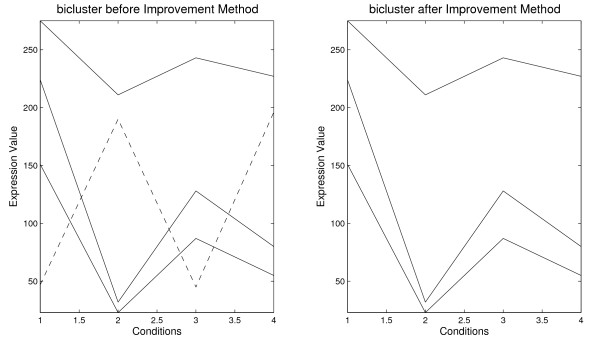
Improvement Method. Bicluster before and after applying the Improvement Method[15123875547190451962243212880275211243227]⇒ρ(B)=0.083[1512387552243212880275211243227]⇒ρ(B)=1